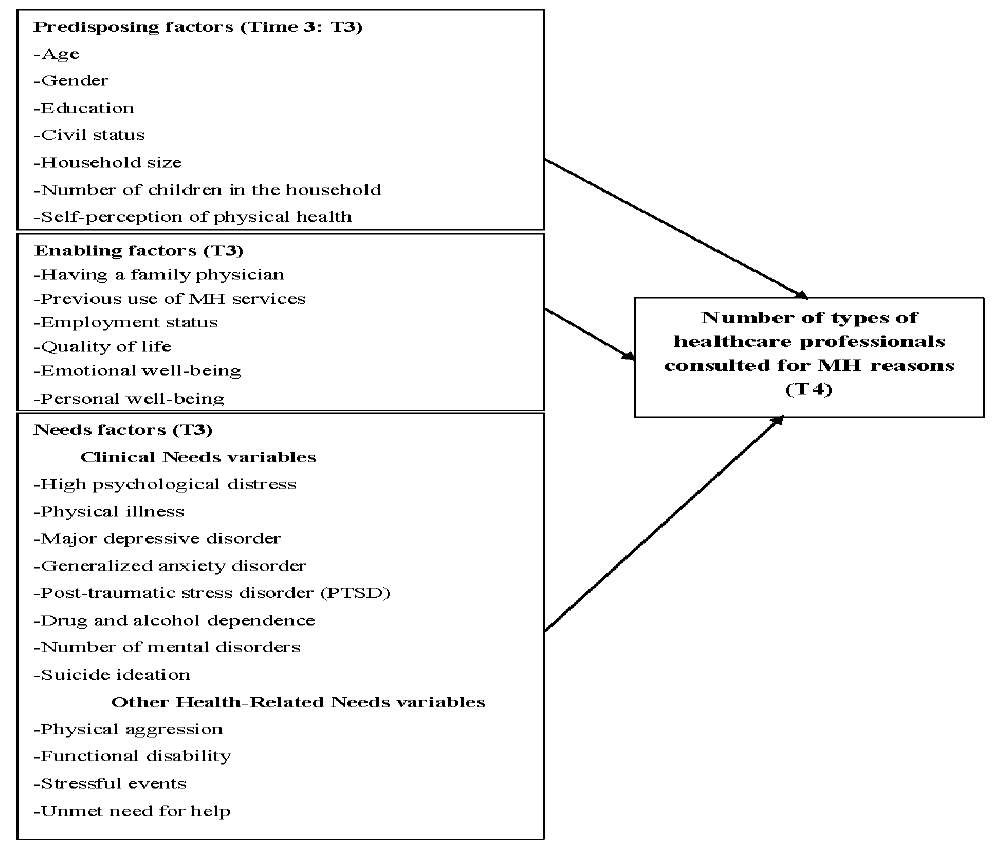
Figure 2. Conceptual framework: (N = 746 individuals with mental disorders (MD) or high psychological distress).